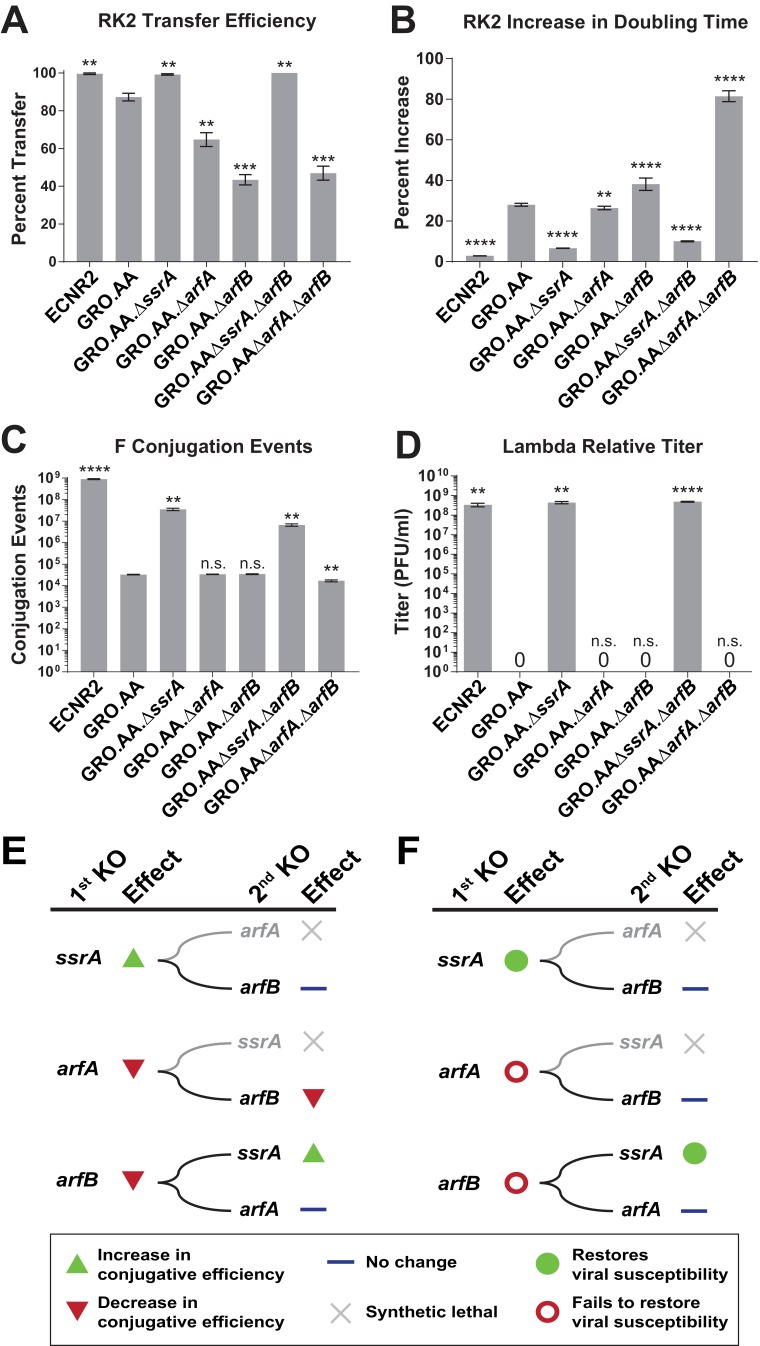
Deleting ssrA restores propagation of both viruses and conjugative plasmids in the genomically recoded organism.(A) Percent transfer of conjugative plasmid RK2 from a wild-type donor into wild-type (WT), GRO, or GRO with designated deletions (KO) as recipients (Figure 4—source data 1). Data are obtained from technical triplicates generated from a single biological sample. (B) Percent increase in doubling time for strains carrying plasmid RK2 compared to strains lacking RK2 (Figure 4—source datas 2 and 3). (C) Number of conjugation events for conjugative plasmid F from wild-type, GRO, or GRO with designated gene deletions as donors to a wild-type recipient (Figure 4—source data 4). Data are obtained from technical triplicates generated from a single biological sample. (D) Relative titer on wild-type, GRO, and GRO with designated deletions of phage λ (Figure 4—source data 5). Error bars show standard deviation centered at mean, n = 3. p-values are calculated in relation to the GRO condition and are as follows: * is p≤0.05, ** is p≤0.01, *** is p≤0.001, and **** is p≤0.0001. (E) Effects of sequential deletions of ribosomal rescue mechanisms on conjugative plasmid transfer efficiency. (F) Effects of sequential deletions of ribosomal rescue mechanisms on viral susceptibility.10.7554/eLife.34878.018Figure 4—source data 1.Analysis of RK2 plasmid conjugation data represented in Figure 4A.Note: These data represent technical triplicates generated from the same biological sample.10.7554/eLife.34878.019Figure 4—source data 2.Growth curve data from 96-well plate assay analyzed using Source code 1, used for data represented in Figure 4B.10.7554/eLife.34878.020Figure 4—source data 3.Analysis of doubling times represented in Figure 4B.10.7554/eLife.34878.021Figure 4—source data 4.Analysis of F plasmid conjugation data represented in Figure 4C.Note: These data represent technical triplicates generated from the same biological sample.10.7554/eLife.34878.022Figure 4—source data 5.Analysis of lambda phage infection data represented in Figure 4D.